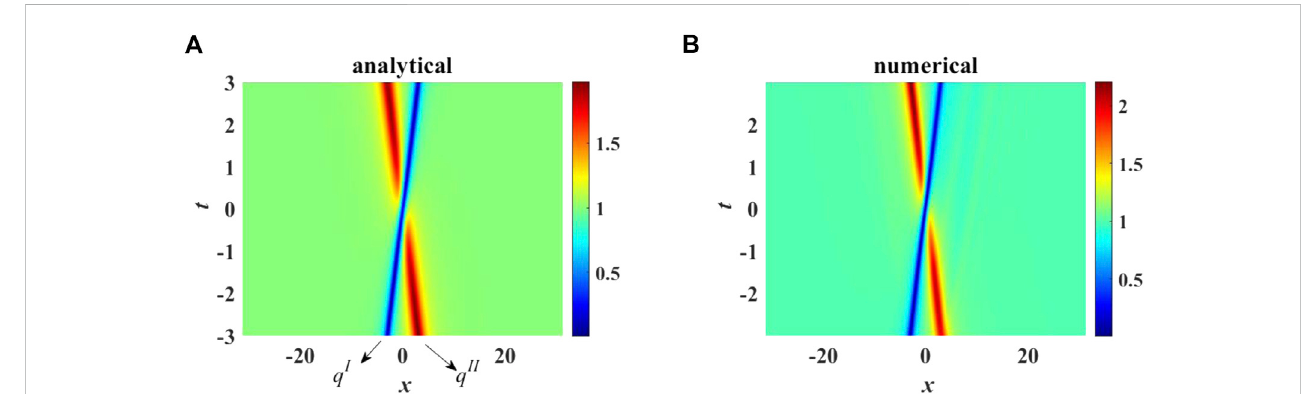
FIGURE 1 (A) Analyticaland (B) Numericalelasticinteractionbetweenarationaldarksolitonandarationalanti-darksoliton.Parameterschosenare κ = − 1, α =1, β = 0.001, ρ = 1.